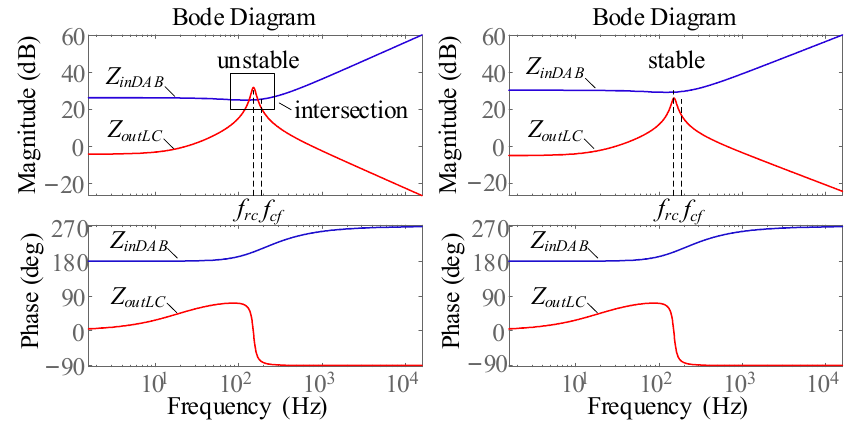
Figure 8. The Bode diagrams of impedance in LC-DAB.